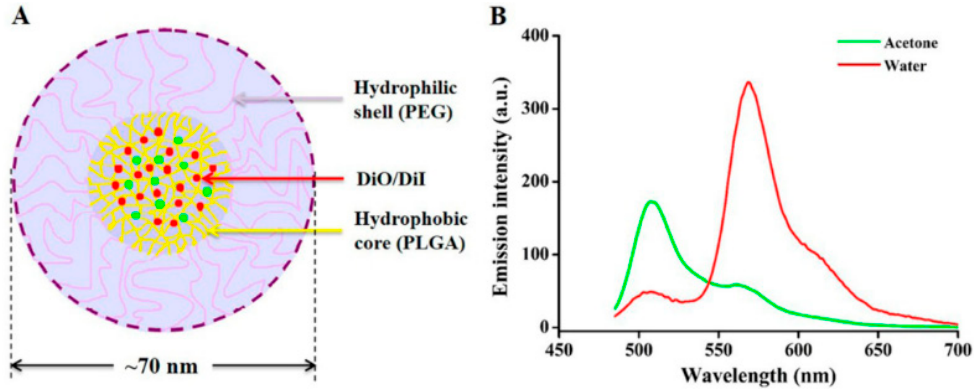
Figure 3. ( A ) Schematic diagram of DiO/DiI (1:1) NPs with each at 0.5% weight ratio of the polymer and ( B ) fluorescence spectra of DiO/DiI NPs with 10-fold dilution in water (red) and acetone (green). Reproduced with permission from Chen, T.; Li, C.; Li, Y.; Yi, X.; Wang, R.; Lee, S.M.Y.; Zheng, Y. Small-sized mPEG–PLGA nanoparticles of Schisantherin A with sustained release for enhanced brain uptake and anti-parkinsonian activity. ACS Appl. Mater. Interfaces 2017 [118].